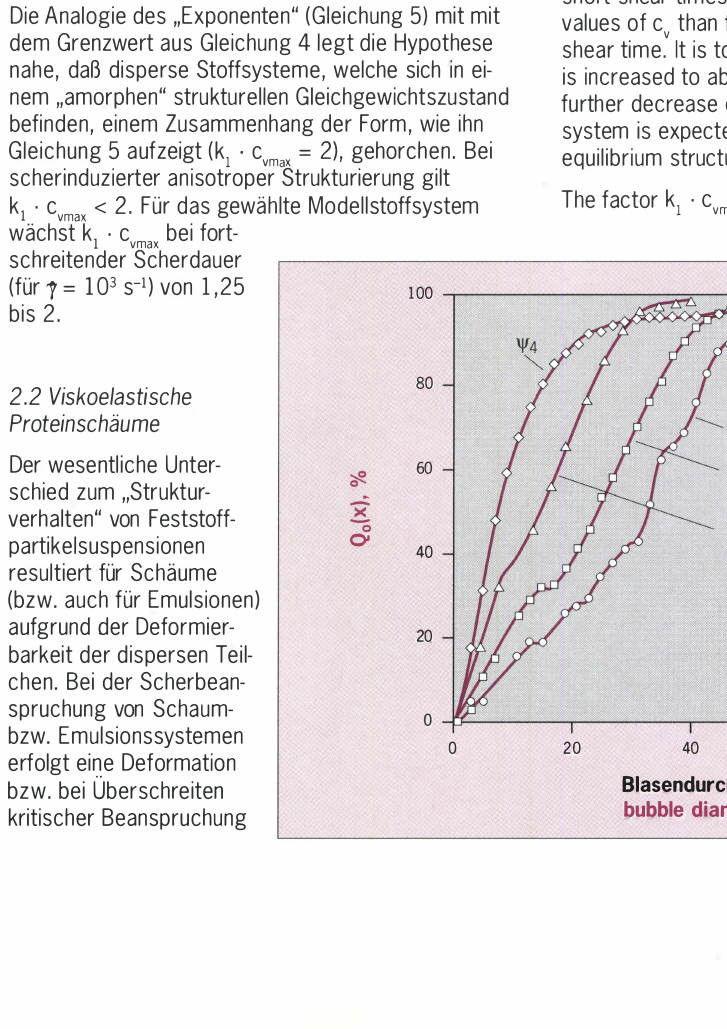
Fig. 5: Bubble size distribu­ tion of a protein foam under conditions of varying shear rate Protein foam (mixture II} equilibrium structure bubble size number frequency distribution